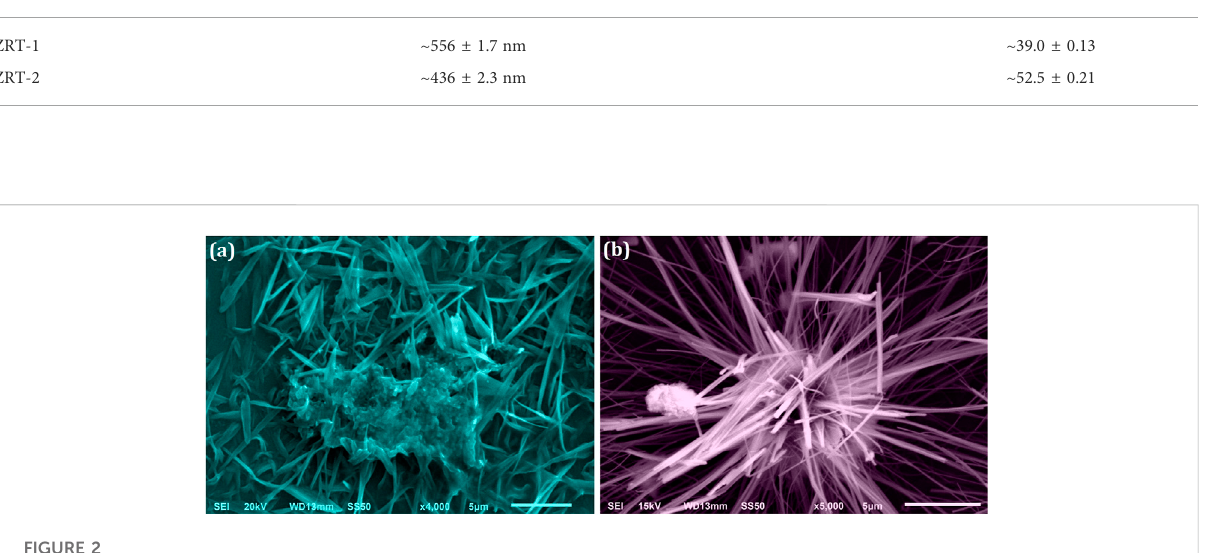
TABLE 1 The effect of introduction time of ion-carriers (NaOH) on the synthesis of ZRTs: ZRT-1 and ZRT-2. ZRT samples